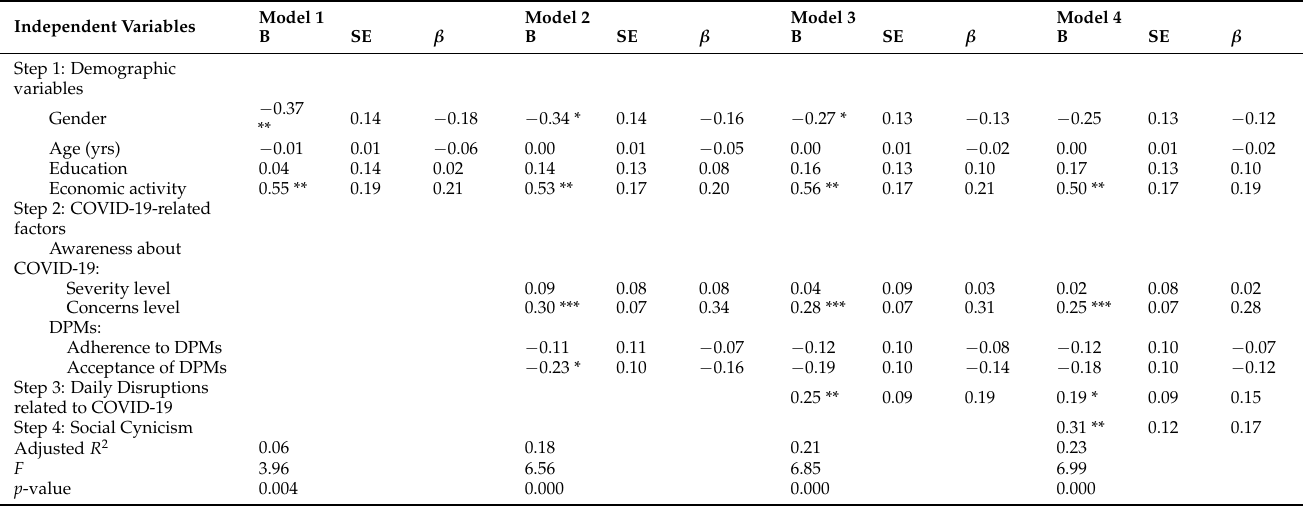
Table 4. Hierarchical Regression Analysis for Escape Motives.